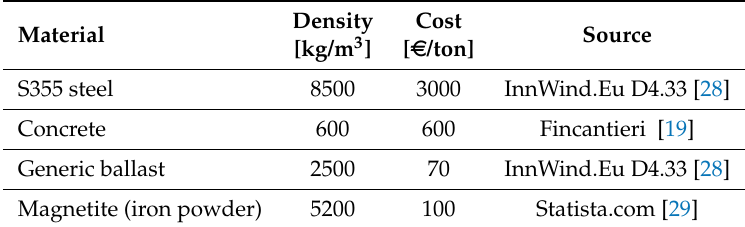
Table 2. Materials